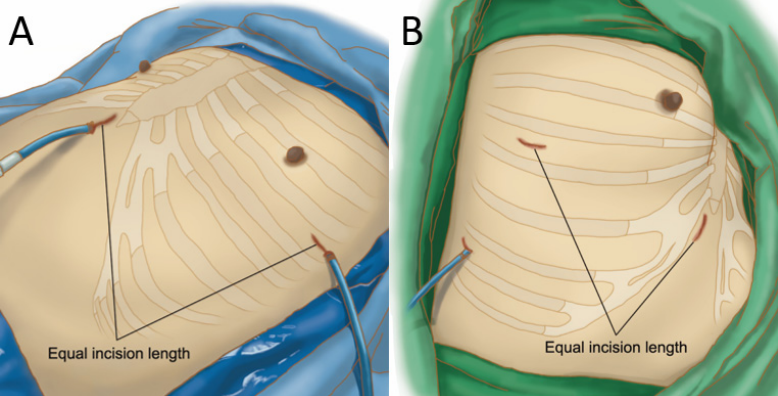
some patients ( n = 3) receiving two equal but separate drains via the subxiphoid and intercostal incisions. In total, 15 patients received no chest drain.